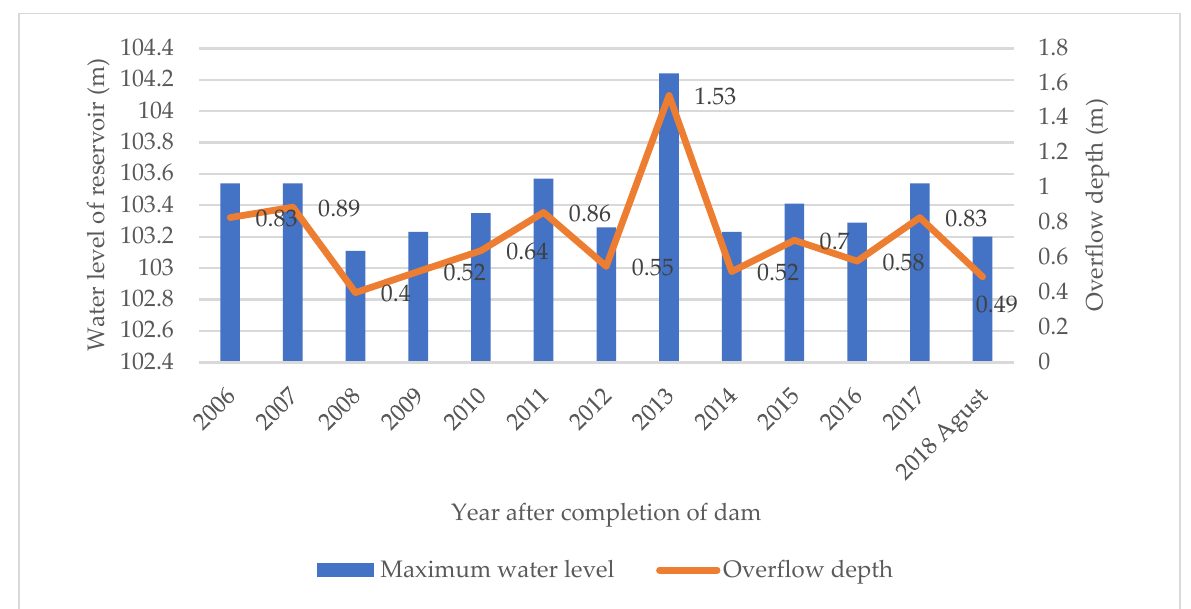
Figure 14. Highest over fl ow depths of the Swa Dam after completion (IWUMD).